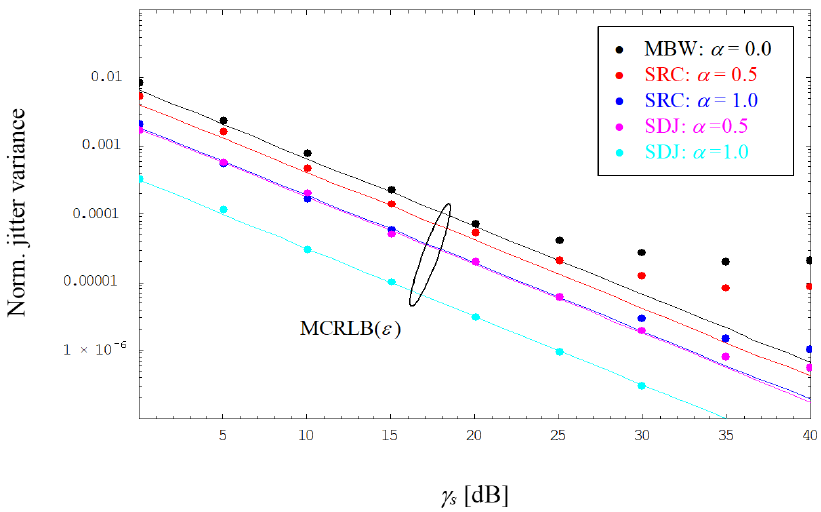
Figure 5. Normalized jitter variance for timing estimates (MF receiver). MCRLB is the modified Cramer-Rao lower bound.